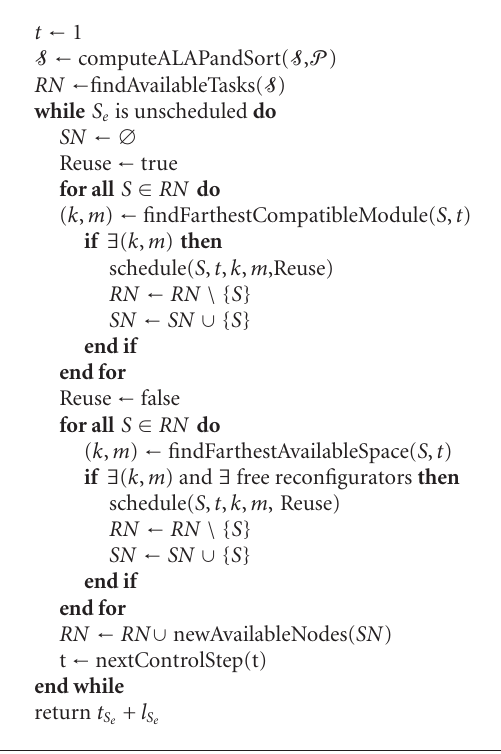
Algorithm 1: Algorithm Napoleon( S , P